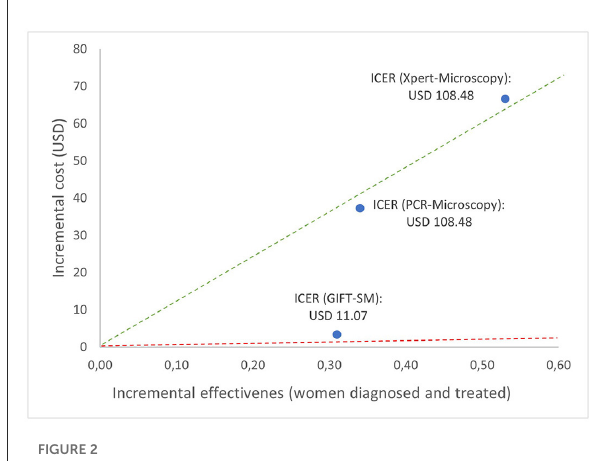
FIGURE2 Cost-effectiveness plane depicting base case ICERs and hypothetical cost-effectiveness